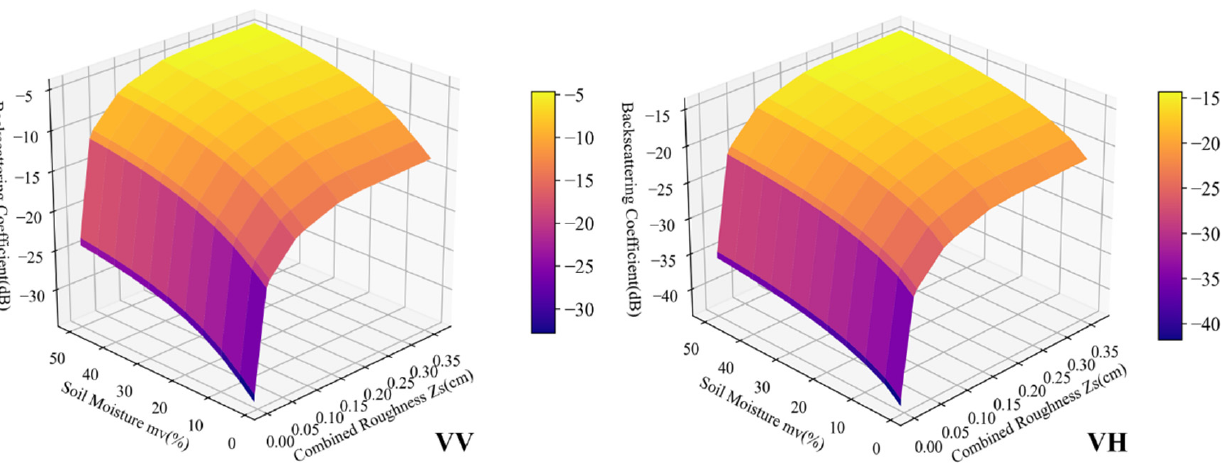
Figure 4. Relationships between soil moisture, combined roughness, and backscattering coefficient in VV and VH